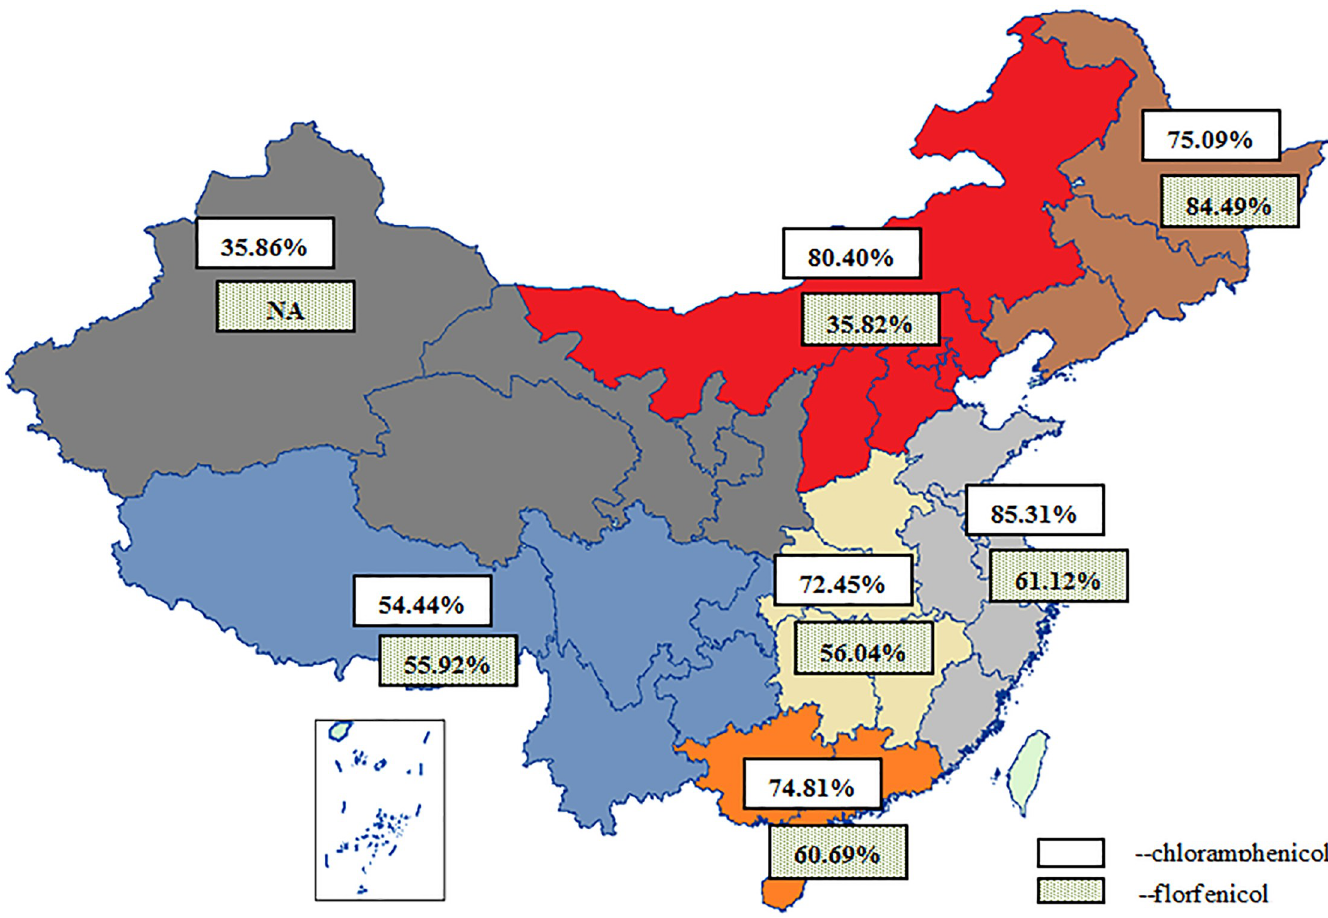
Fig 2. Drug-resistant status in the different regions of